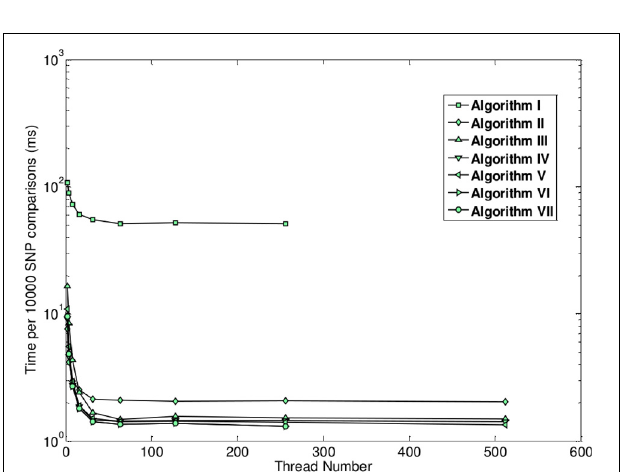
FIGURE 5 | Candidates from BOOST first stage screen (figure from Wan et al., 2010).